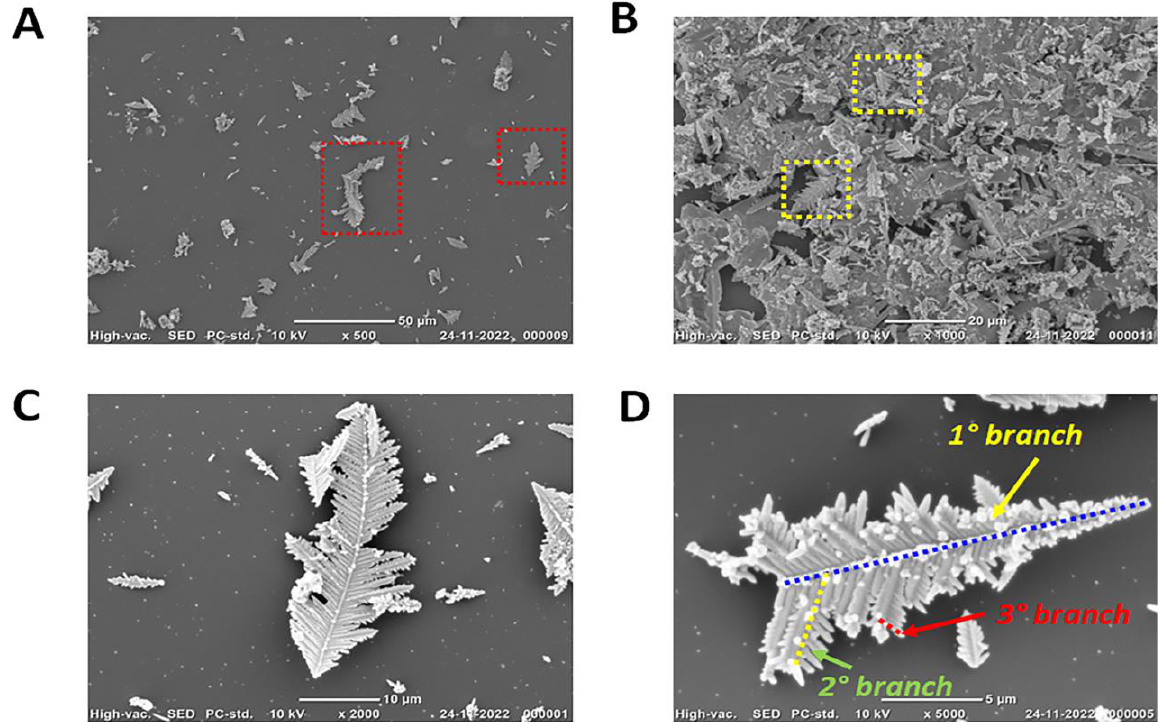
Figure 1. SEM images of imprinted trimetallic NDs at 50 µm, 20 µm, 10 µm, and 5 µm magnification, respectively ( A – D ).